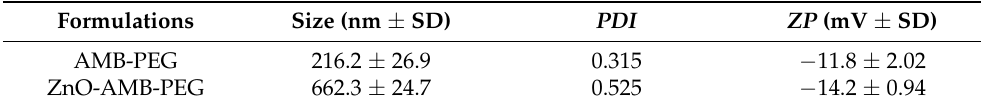
Table 1. Particle characterization of AMB nanoparticles.